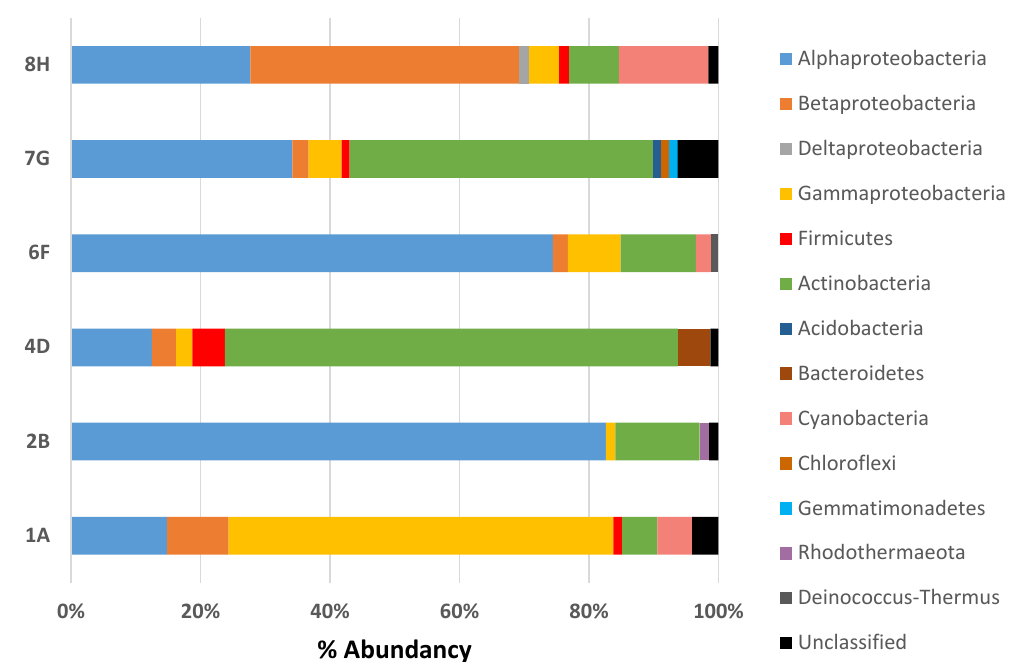
Figure 3. Distribution of bacterial phyla retrieved from samples 1A (mill ceramic suspension), 2B (talc 1), 4D (clay), 6F (barium carbonate), 7G (talc 3) and 8H (tank ceramic slip).